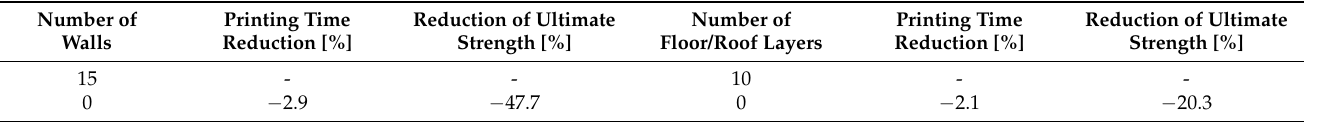
Table 9. Influence of the selected printing parameters on the reduction of printing time and ulti- mate